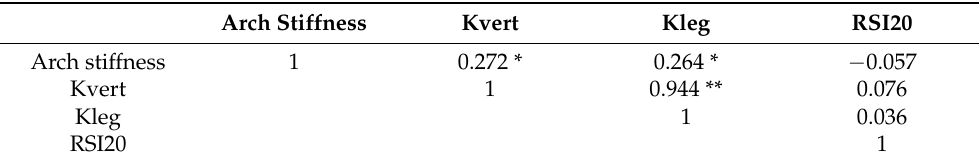
Table 4. Partial correlation analysis (r coefficient), adjusted by age, between arch stiffness, lower-body stiffness during running, and reactive strength index obtained from drop jumping. Arch Stiffness Kvert Kleg RSI20 Arch